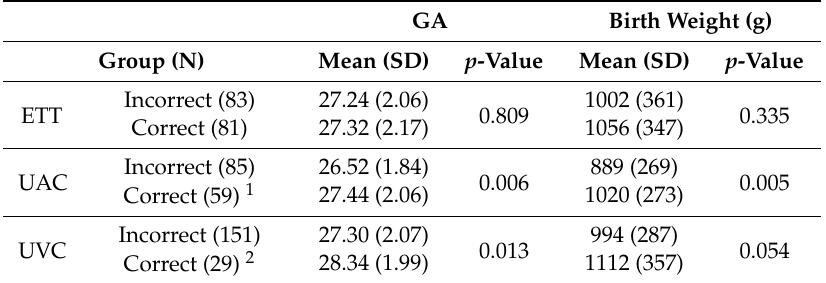
Figure 1. Accuracy of initial position in pre (black) and post (white)-education groups. Table 2. Comparison of GA and birth weight between incorrect and correct positioning.